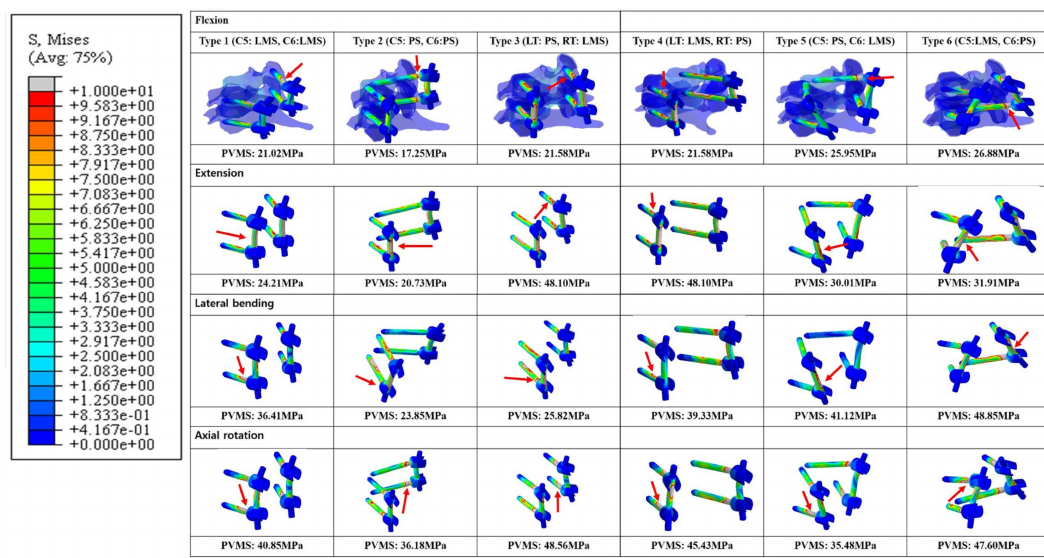
Figure 6. Posterior and lateral views of the Peak von Mises stress distributions on the screw-bone interface. *Red arrows indicate the highest stress distributions. Type 1: all LMS, Type 2: all PS, Type 3: left (Lt) PS and right (Rt) LMS, Type 4: Lt LMS and Rt PS, Type 5: upper PS and lower LMS, and Type 6: upper LMS and lower